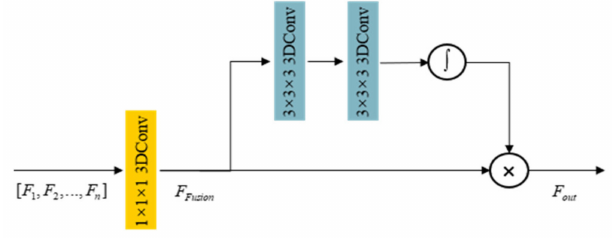
Figure 4. Architecture of the